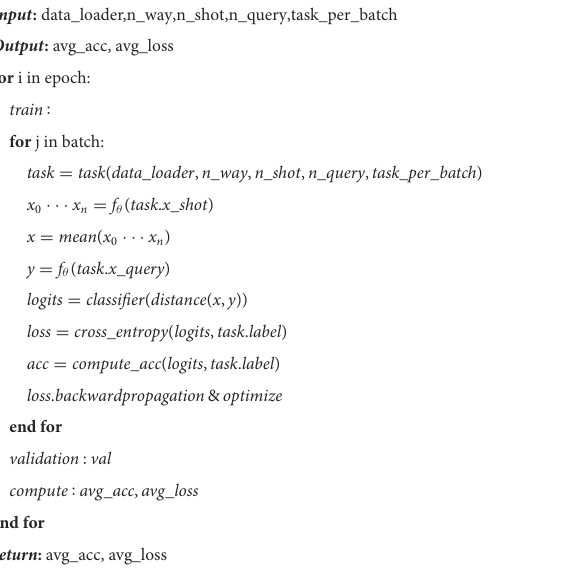
TABLE 2 The algorithm of meta-learning. Algorithm of